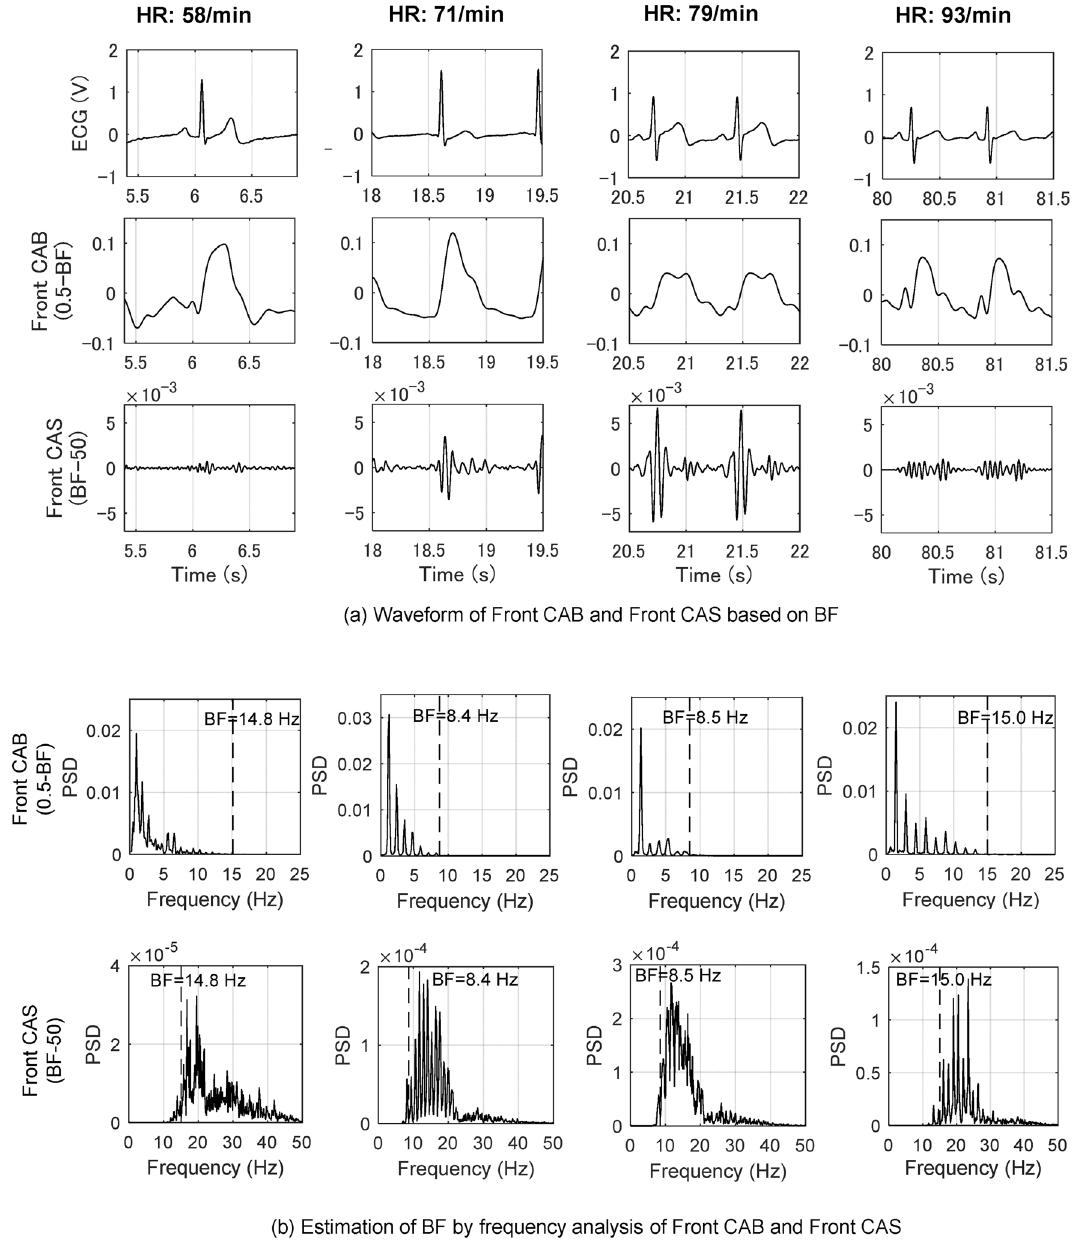
Figure 4. Extraction of CAB and CAS from F-APW and confirmation of BF. (a) According to Fig. 3, BF of the same subjects as Fig. 2 (heart rates are 58, 71, 79 and 93/min) were 14.8, 8.4, 8.5 and 15.0 Hz, respectively. CAB in the range of 0.5 Hz to BF and CAS in the range of BF to 50 Hz were extracted from F-APW collected from the precordial region based on BF. Front CAB (0.5-BF) resembles apex beat wave, and CAS resembles PCG. (b) Frequency analysis was conducted of Front CAB and Front CAS obtained from F-APW of the four same subjects based on BF determined in Fig. 3. It was revealed that the higher harmonic components of Front CAB decreased and converged in the vicinity of each